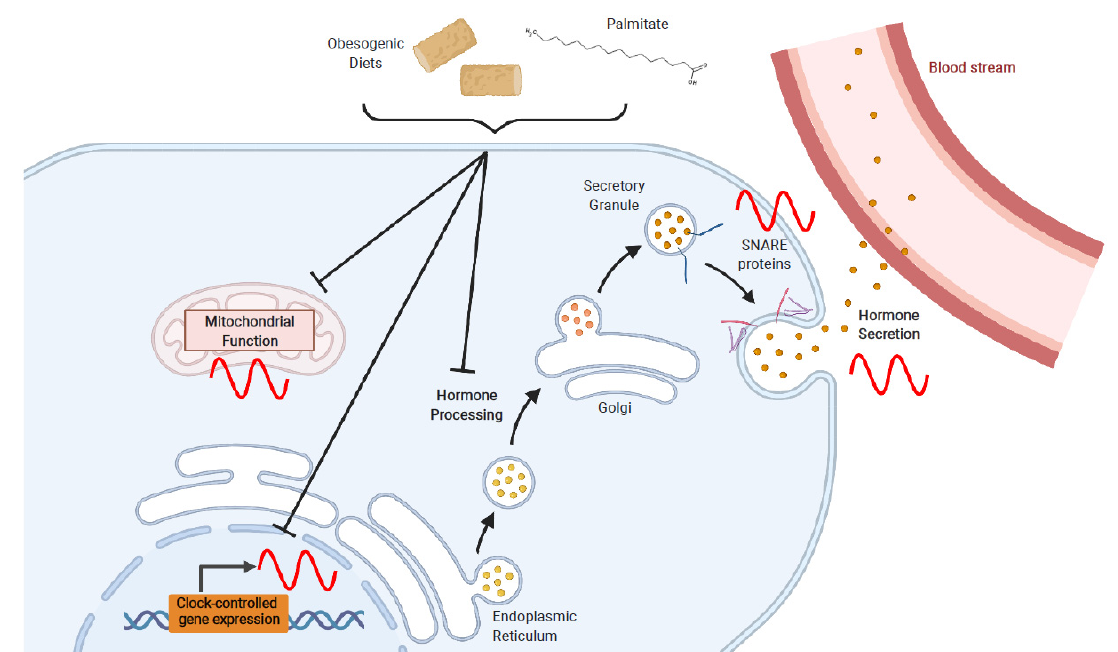
Figure 3. Circadian clock driven expression of key cellular pathways establishes rhythmic hormone release from the intestinal L cell and the pancreatic β cell. Ultimately, circadian secretion results from the rhythmic expression of key SNARE proteins involved in exocytosis. The obesogenic diet and its major component, the saturated fatty acid palmitate, have been shown to disrupt key L and β cell processes including clock and clock-controlled gene expression, mitochondrial function, and hormone processing through induction of ER stress. Collectively, exposure to high fat results in impaired rhythmic hormone secretion from both of these endocrine cell types. Figure created with BioRender.com.